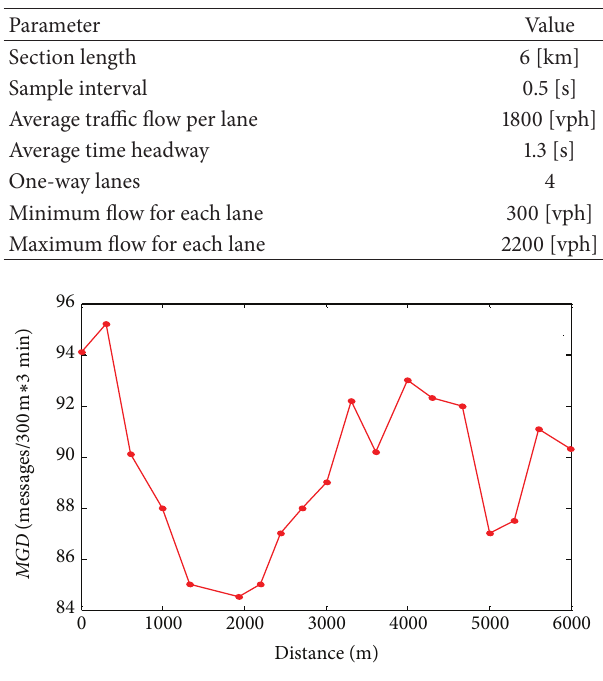
Figure 4: Simulation verification process.